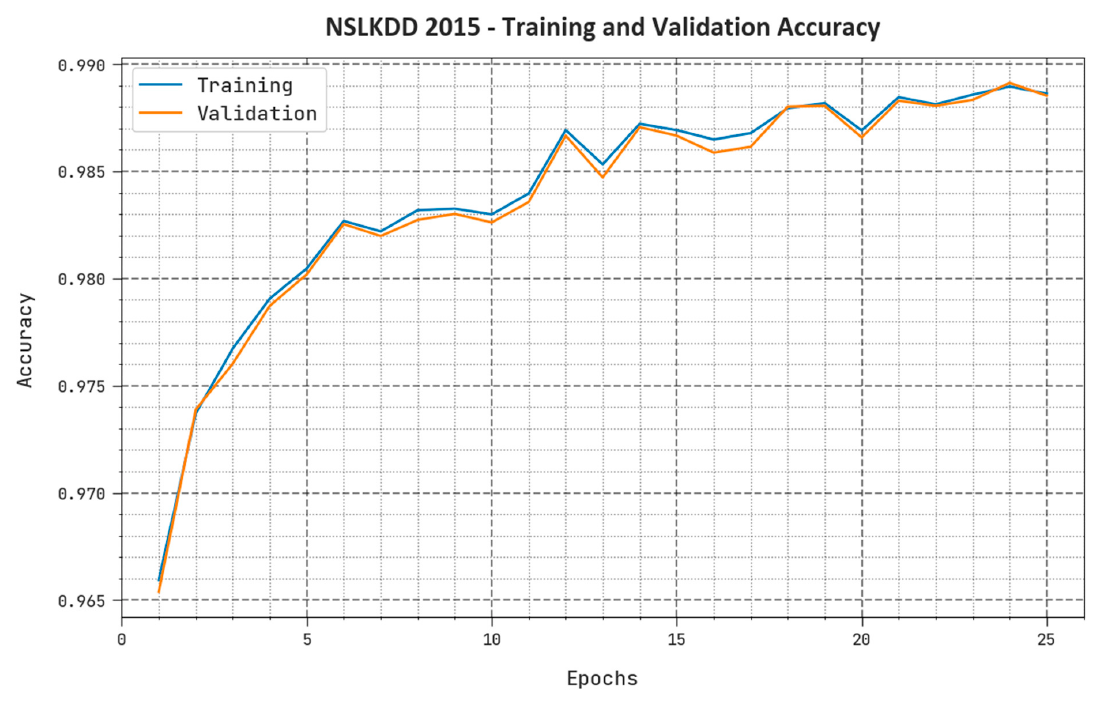
Figure 4. TACY and VACY outcome of XAIID-SCPS system on NSLKDD2015 dataset. The TLOS and VLOS of the XAIID-SCPS model on the NSLKDD2015 dataset are represented in Figure 5. The figure inferred that the XAIID-SCPS model has superior performance with least values of TLOS and VLOS. It is visible that the XAIID-SCPS model has resulted in reduced VLOS outcomes.